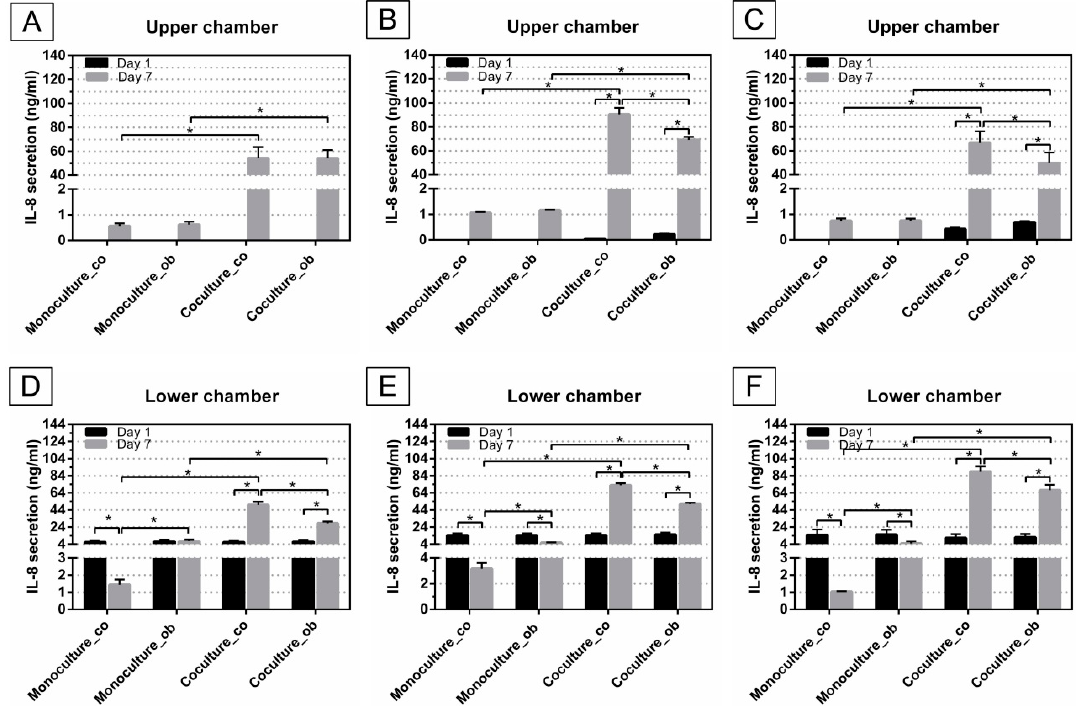
Figure 7. Analysis of IL-8 secretion in supernatants from upper and lower chamber of mono- and co-cultures, before and after DC differentiation (at day 1 and day 7). PBMCs/DCs were cultured in mono- and co-cultures with JPCs (untreated—co or osteogenically induced for 7 ( A , D ); 14 ( B , E ); and 21 ( C , F ) days) and IL-8 levels in supernatants from upper chambers of co-culture plates (upper panel) and lower chambers of co-culture plates (lower panel) were quantified by ELISA. Results were averaged from 6 independent experiments.